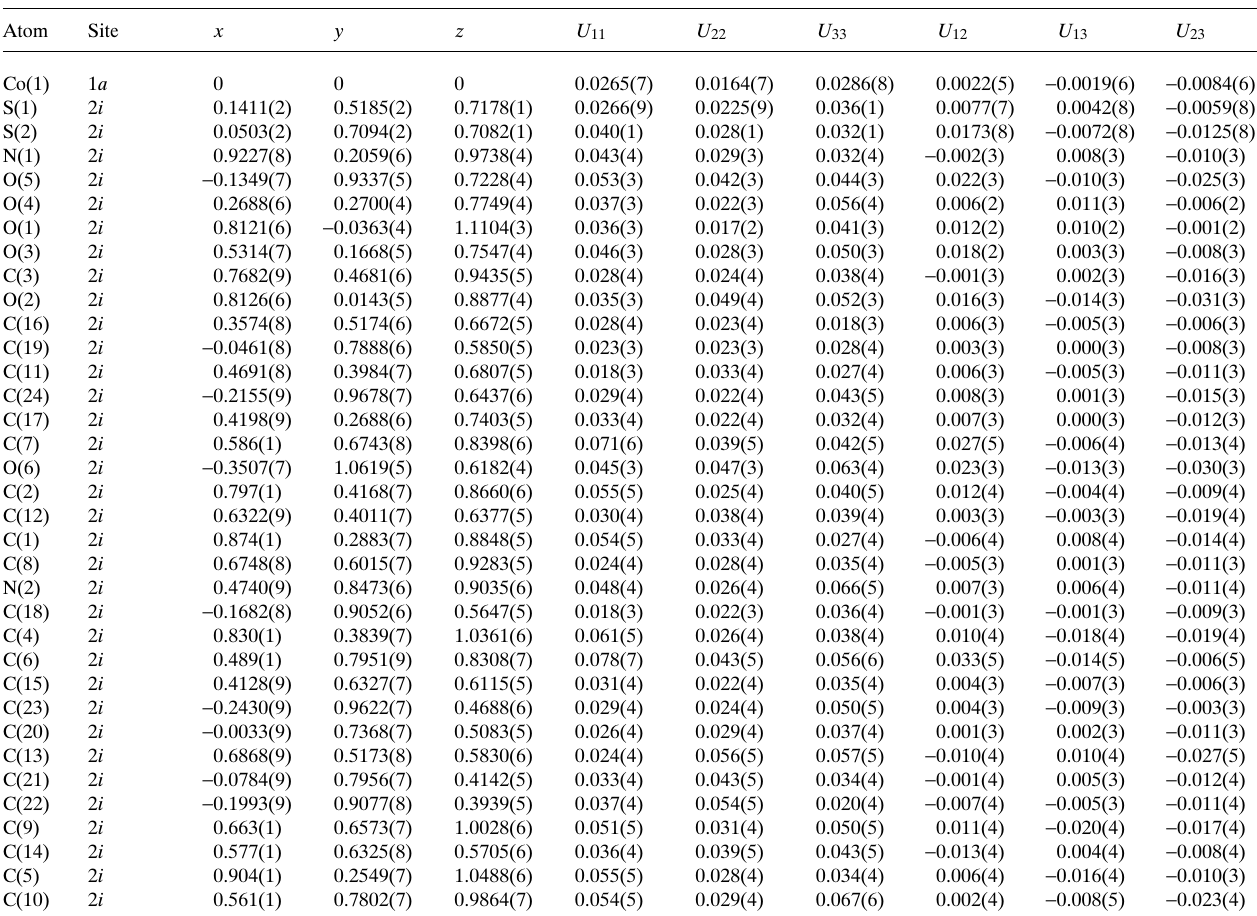
Table 3. Atomic coordinates and displacement parameters (in Å 2 ) .